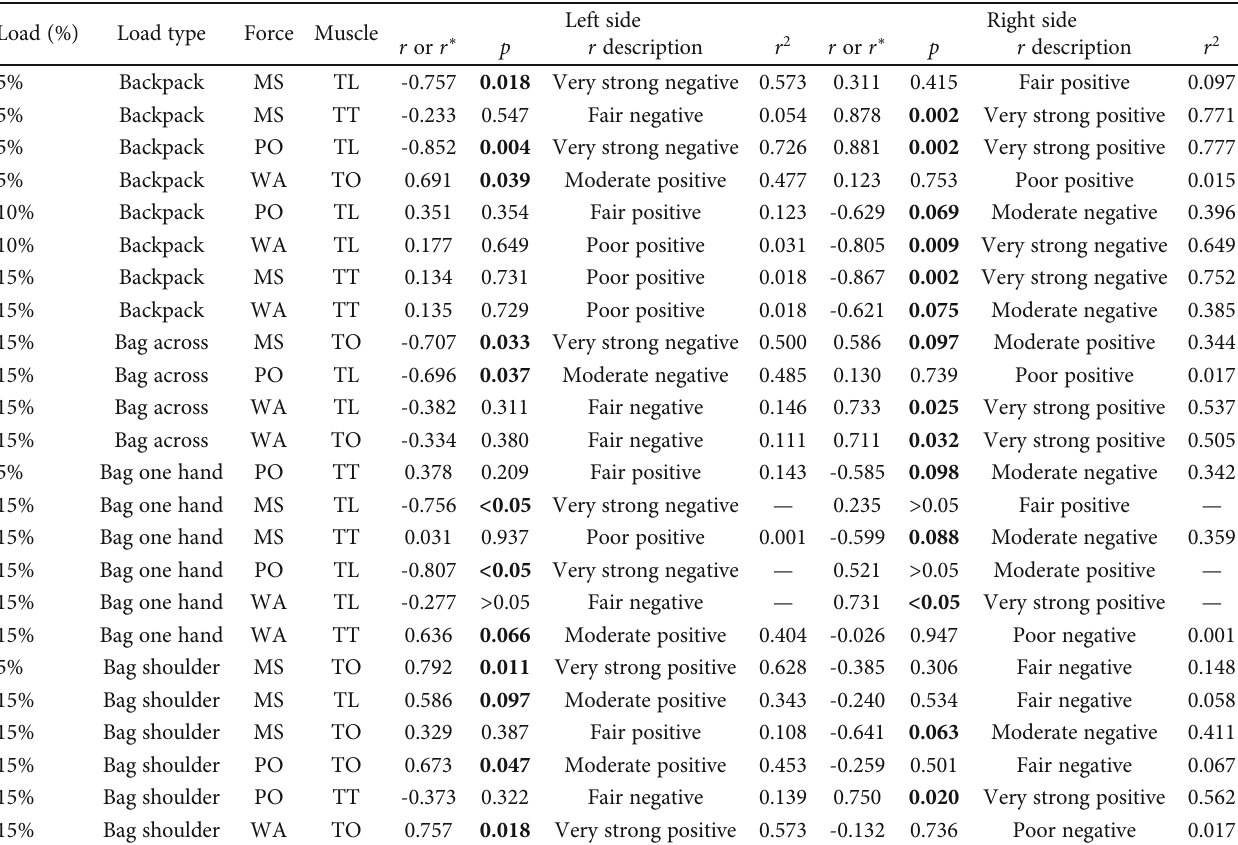
Table 1: Statistical relationships between thermal and force parameters for three muscle groups: trapezius (TT), latissimus dorsi (TL), and obliquus abdominis (TO), and three ground reaction force values: maximal weight acceptance force (WA), maximal force in midstance (MS), and maximal force in push-o ff gait phase (PO), for the left and right leg, respectively. Signi fi cant relations ( p < 0 : 1 or p < 0 : 05 for Spearman ’ s test) are written in